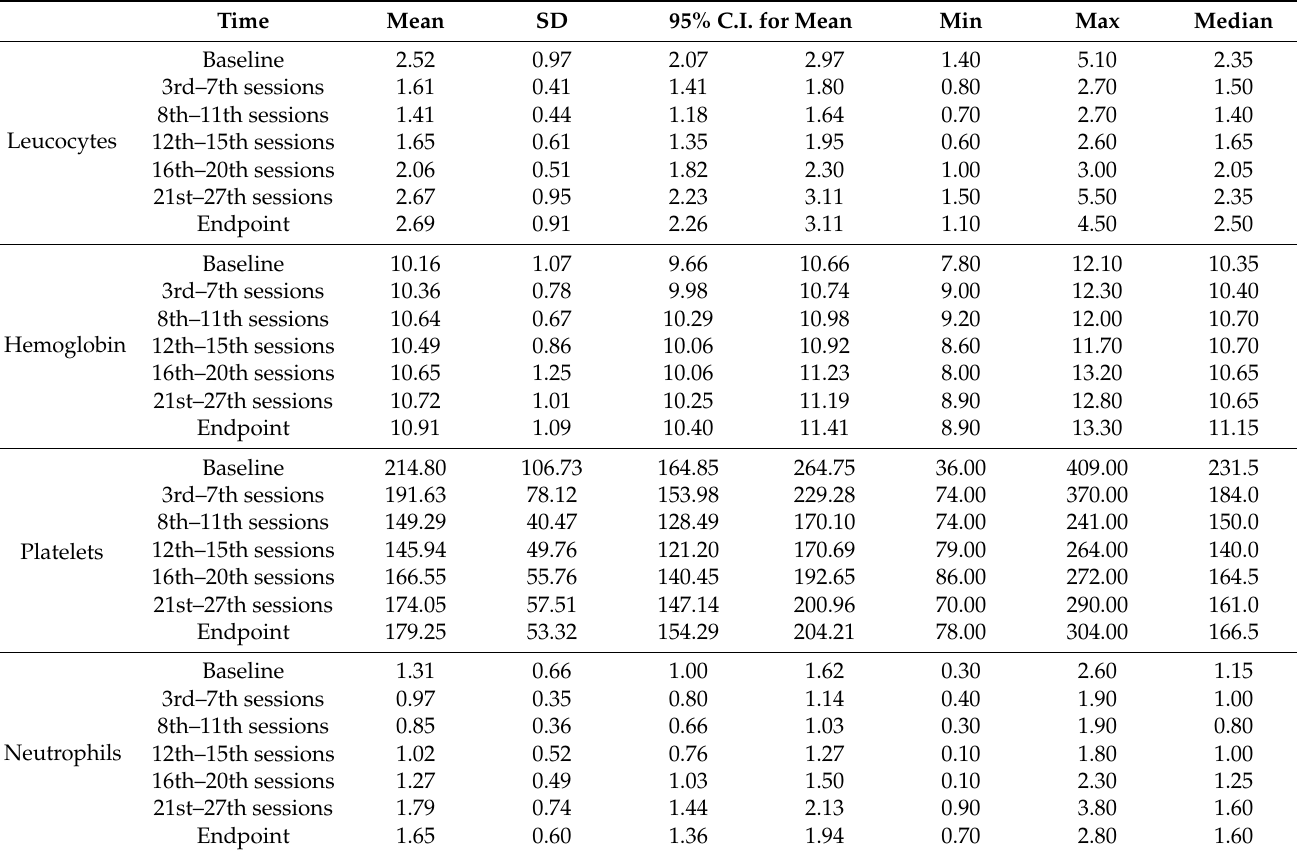
minimum, maximum, and median) for leucocytes, hemoglobin, platelets, and neutrophils at different times over the proton treatment course. In between the baseline and end of treatment, the values of the parameters are provided as average values grouping several treatment